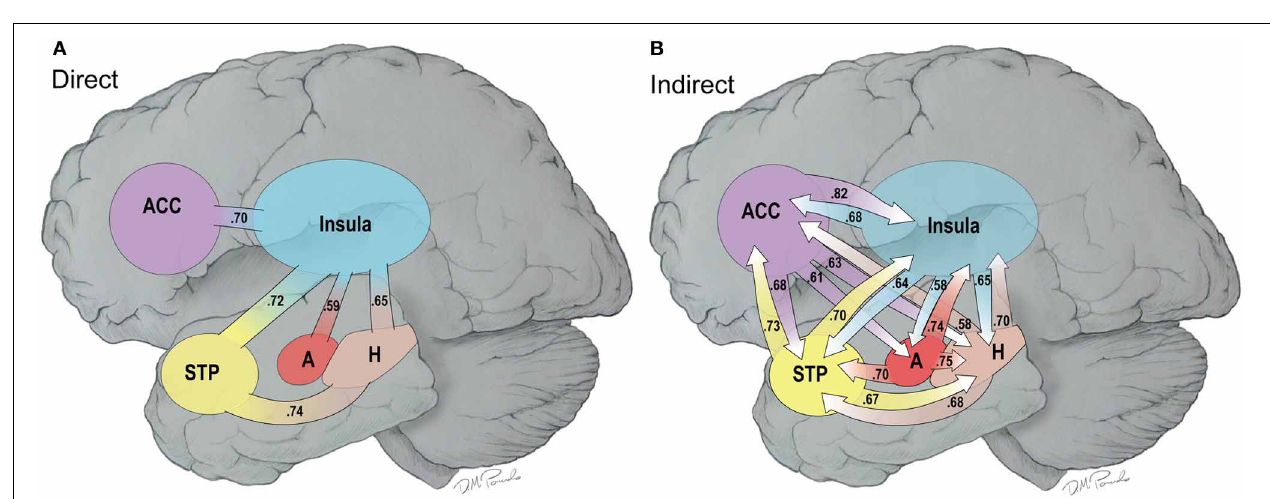
on the bottom demonstrate the total number of indirect connections from the right hippocampus averaged across individuals. These images demonstrate that the right hippocampus has a greater number of indirect connections to the STP, ACC, and the insula during the water condition than the MR